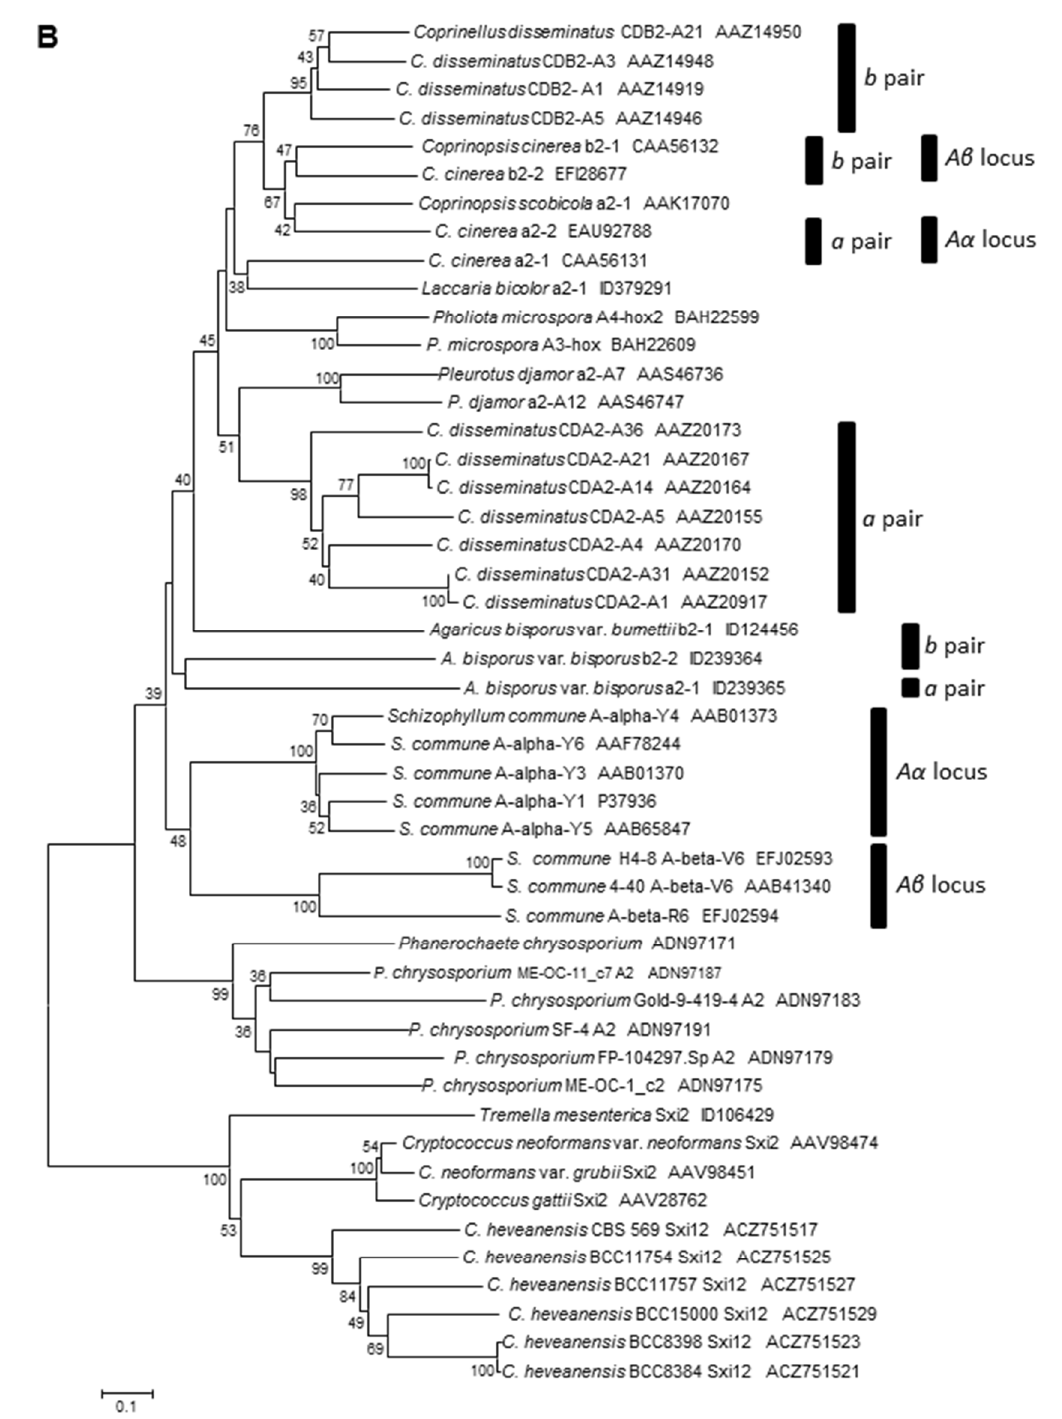
Figure 5. Phylogenetic analysis of the N-terminal dimerization domains and the homeodomains of ( A ) HD1 and ( B ) HD2 proteins from Agaricomycotina. Bars mark paralogous proteins from fungi with more than one HD1 - HD2 gene pair. Proteins with N-terminal truncations ( A. bisporus var. bisporus H97 b2-1, Tremella mesenterica Sxi2) in the ClustalW alignment were manually adjusted to assign them appropriately in position. Extra aa were added to the short N-terminal sequence of C. cinerea a2-2 from EAU92788 since the non-functional gene contains a preliminary stop codon in the 5 (cid:48) end of the gene shortly after the normal ATG start codon [85]. Proteins from Tremellomycetes served as outgroup. Accession numbers refer either to NCBI GenBank or to protein IDs at the fungal JGI